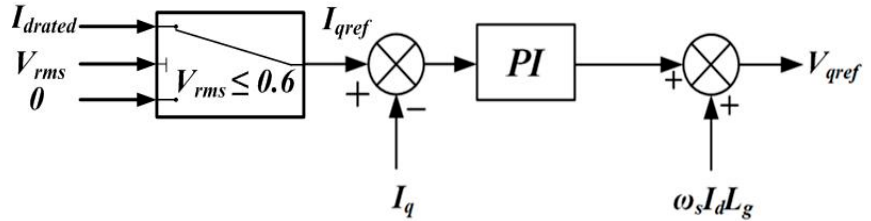
Figure 6. Proposed controller (ARS) for the q -axis control block.